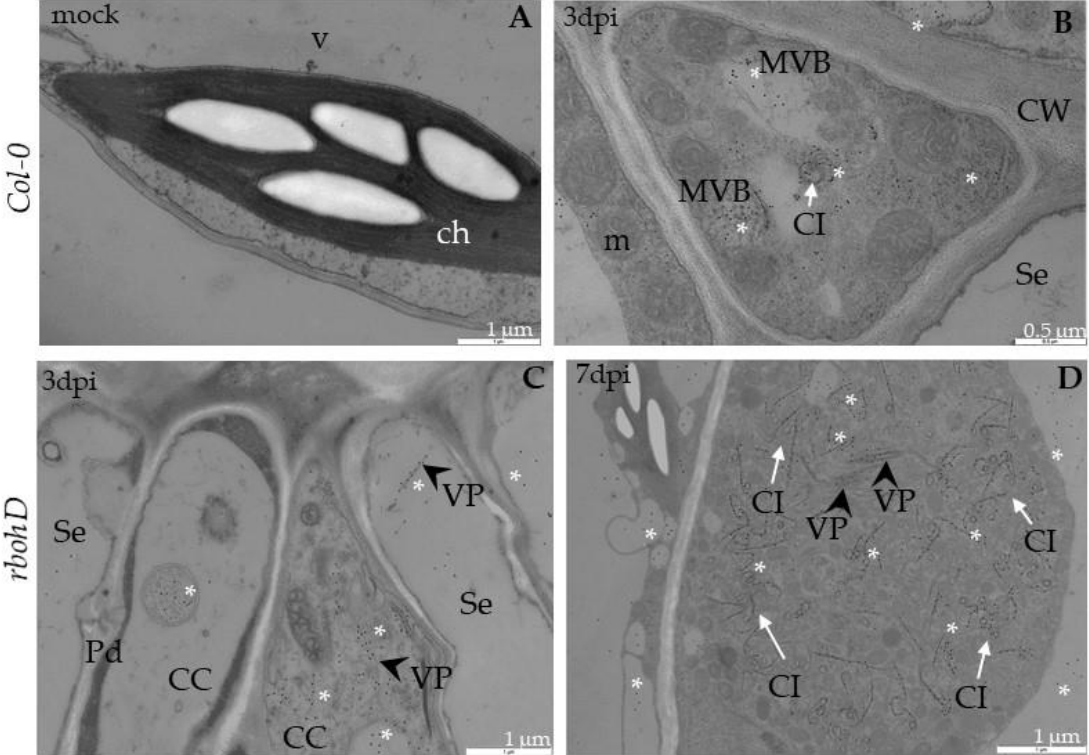
Figure 6. TuMV detection in Col-0 and rbohD mock-inoculated leaf tissues ( A ) and 3 ( B , C ) and 7 days ( D ) after virus inoculation by immunogold electron microscopy. ( A ) Unchanged palisade mesophyll cell without TuMV epitope from mock-inoculated Col-0 plants. ch—chloroplast; v—vacuole. ( B ) TuMV epitope presence (*) around cytoplasmic inclusion (CI; arrow) and multivesicular bodies (MVBs) in phloem parenchyma cell of Col-0. CW—cell wall; m—mitochondrion; Se—sieve tube. ( C ) TuMV epitope localization (*) along virus particles (VPs; arrowhead) in companion cell (CC) and sieve element (Se) in rbohD phloem tissue. Pd—plasmodesmata. ( D ) TuMV epitope presence (*) around virus particles (VPs; arrowhead) and cytoplasmic inclusion (CI; arrow) in vesicular structures in rbohD palisade mesophyll cells.